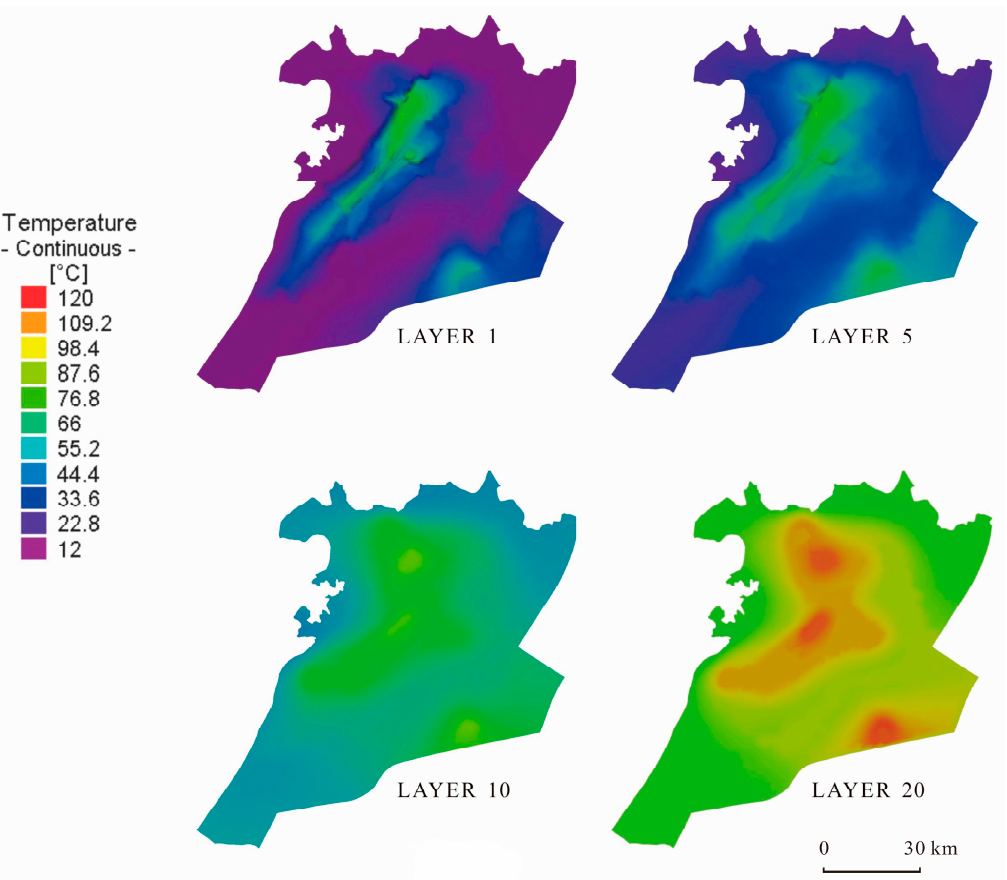
Figure 11. Distribution of temperature of groundwater at the beginning of the simulated period.